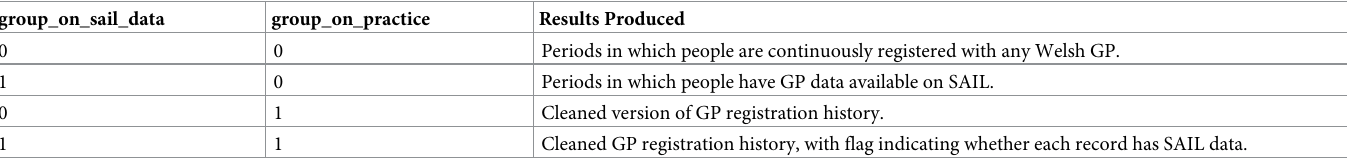
Table 1. Effects of combinations of two grouping